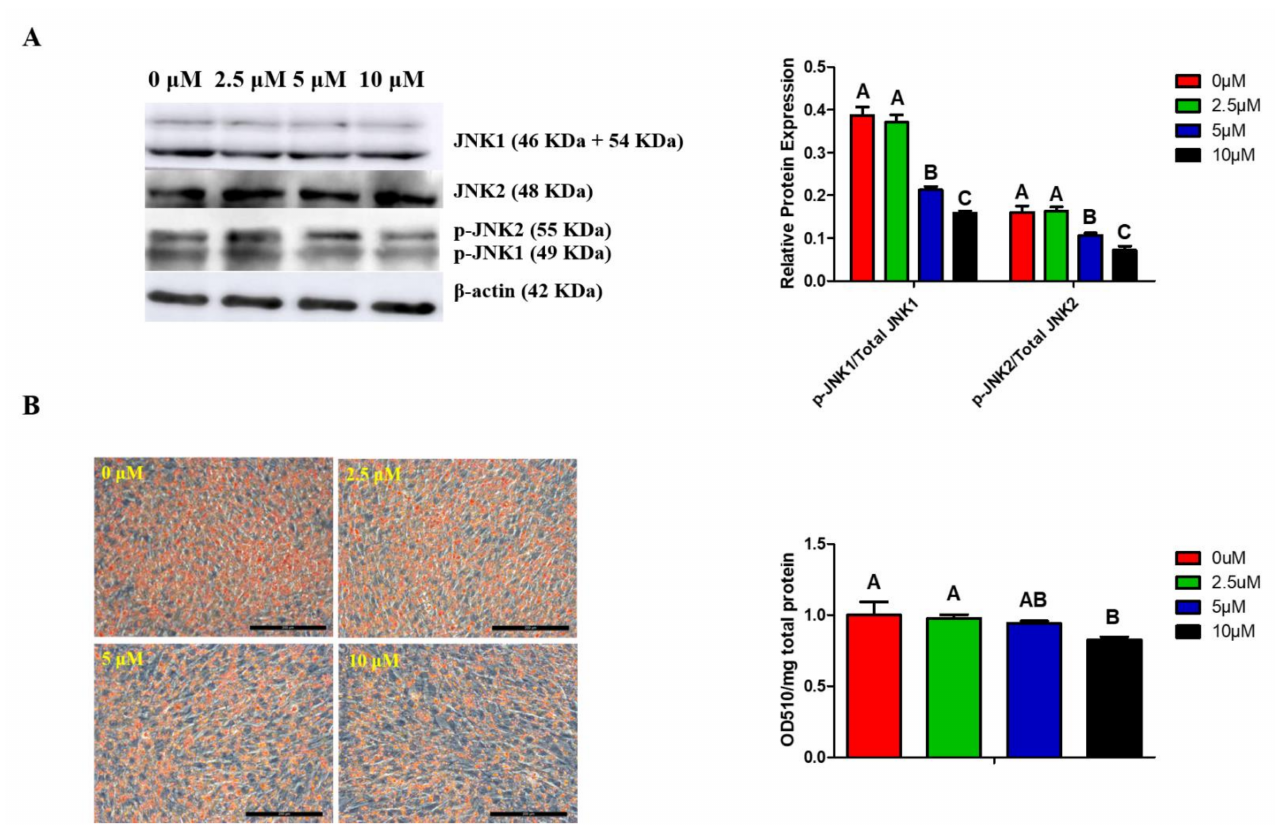
Figure 2. MAPK/JNK signaling and lipid droplets accumulation were inhibited by SP600125 in a dose-dependent manner. At 24 h post-induction of differentiation, ICP cells were then incubated for an additional 24 h in differentiation medium containing 0, 2.5, 5, or 10 µ M SP600125. ( A ) Images for JNK1, JNK2, p-JNK1, p-JNK2, and β -actin expressions in cells treated with different concentrations of SP600126 by Western blotting (representative of three independent experiments). Then, the bands intensities were quantified by Image J software. Graphs are plotted as mean ± SE from three independent experiments. Different uppercase letters above columns denote significant differences; ( B ) images for oil-red O staining of lipid droplets in preadipocytes treated with different concentrations of SP600125 (representative of three independent experiments). Then, oil-red O dye was extracted from the cells treated with different concentrations of SP600125 in order to quantify staining intensity. Graphs are plotted as mean ± SE from three independent experiments. Different uppercase letters above columns denote significant